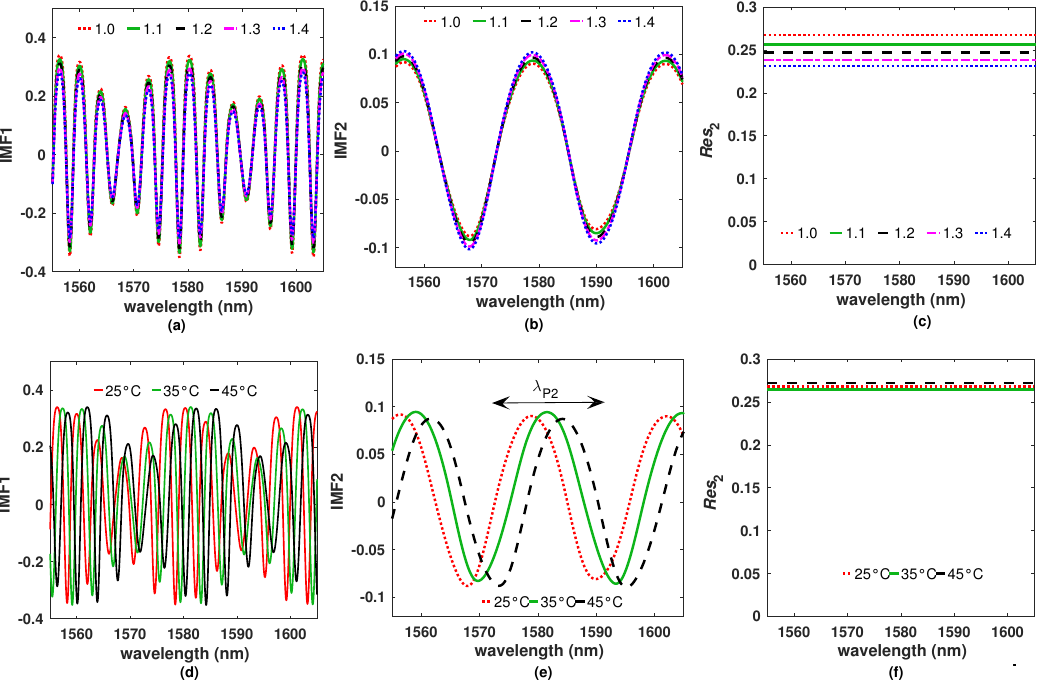
Figure 7. R spectra decomposed into ( a ) IMF1, ( b ) IMF2 and ( c ) Res 2 for different n 4 values and T = 25 °C. Simulated ( d ) IMF1, ( e ) IMF2 and ( f ) Res j considering n = 1 and different T